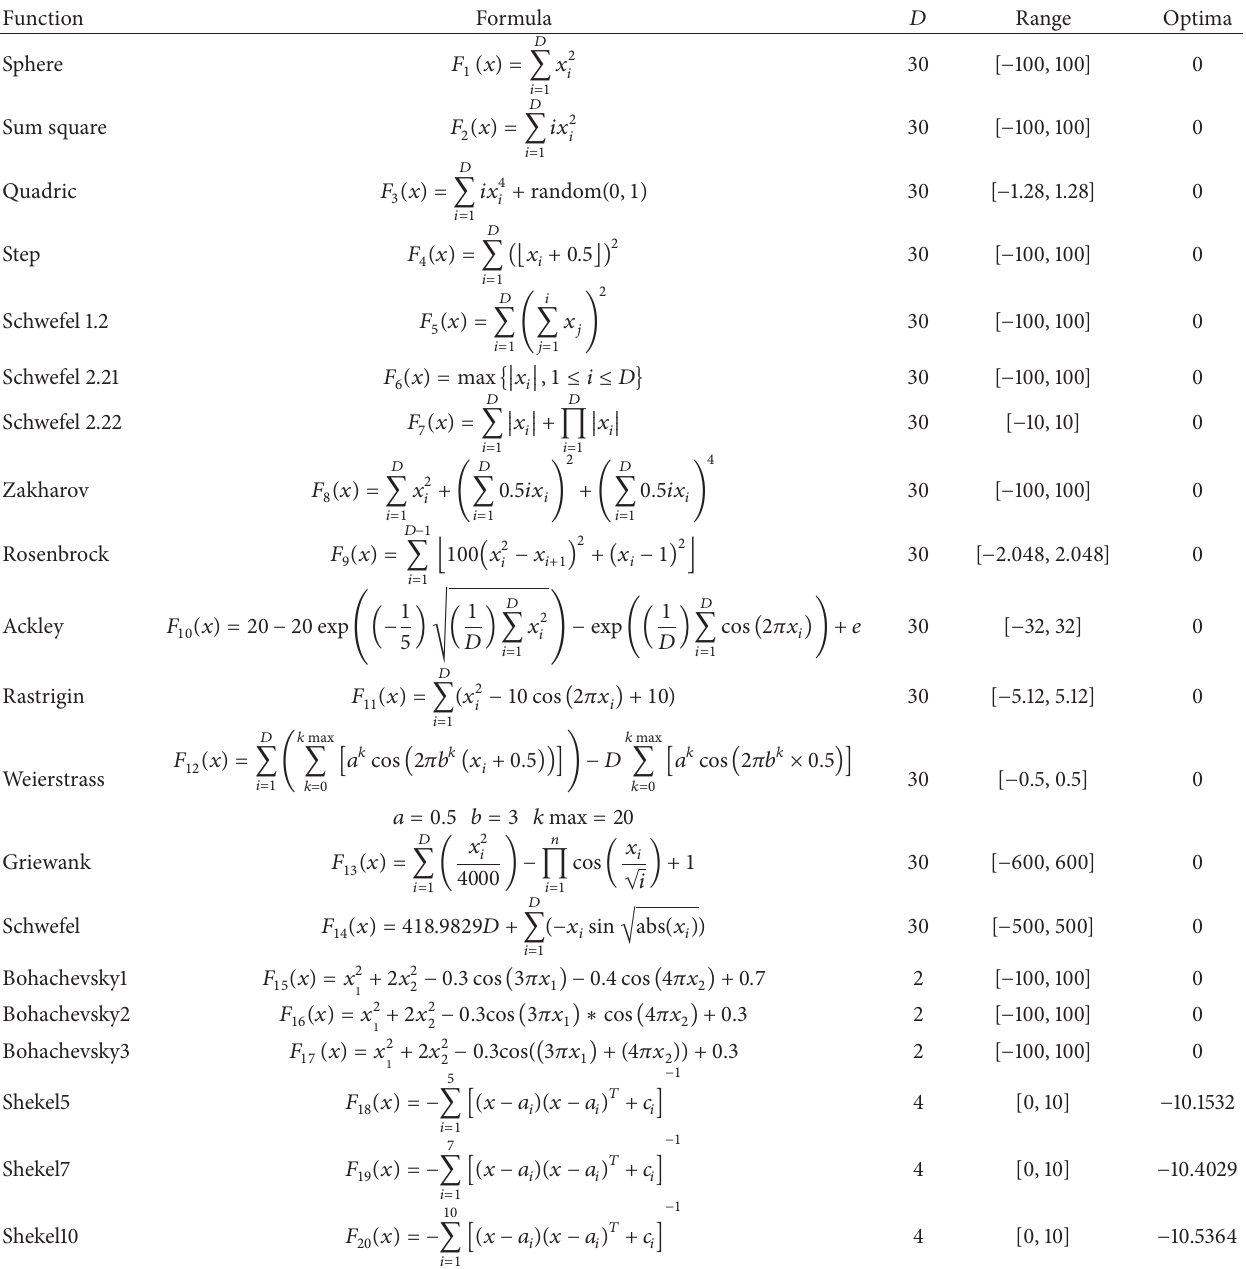
Table 1: Details of numerical benchmarks